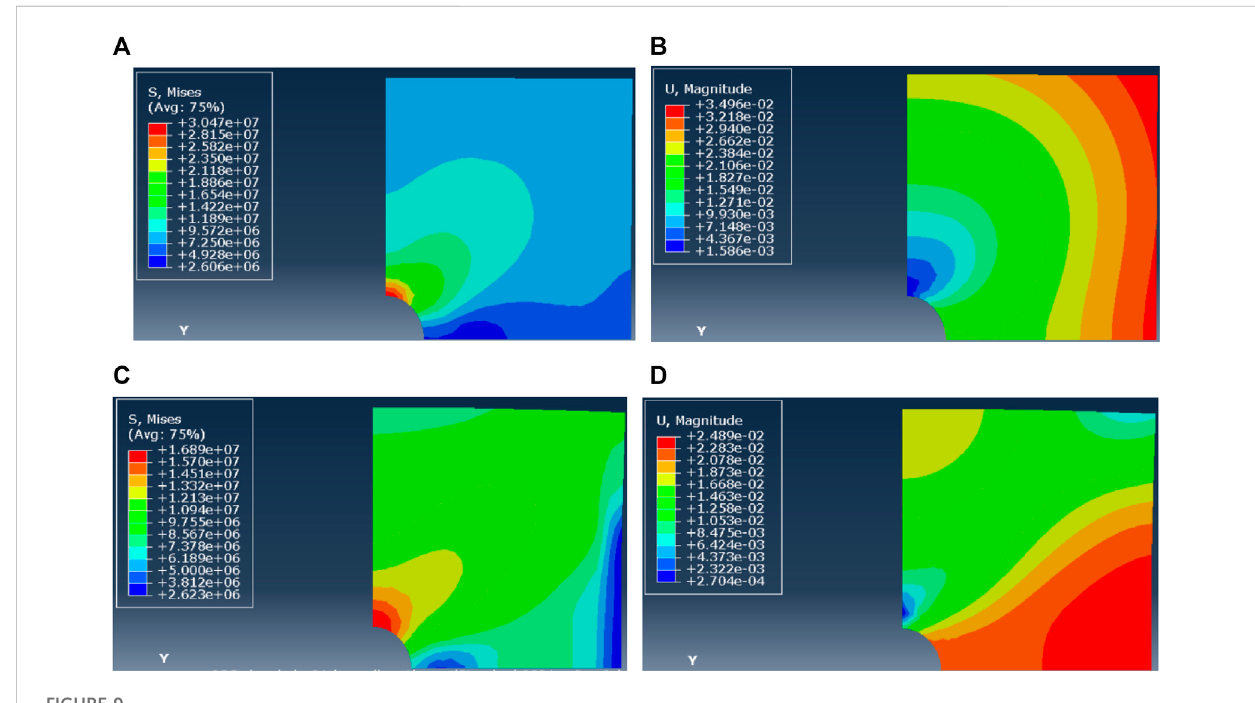
FIGURE 9 (A – D) Mises stressand displacement ofborehole shrinkage after reaming( Δ P= 10 MPa, n= 1).Misesstress anddisplacement ofborehole shrinkage after reaming ( Δ P = 10 MPa, n =